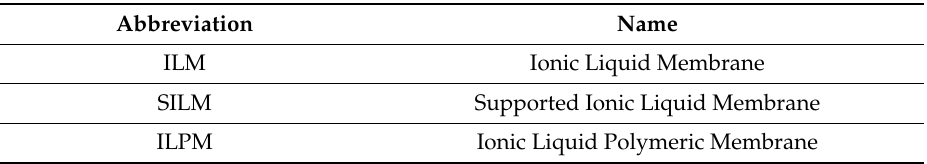
Table 1. Names and abbreviations of the principal Ionic liquid membranes and the primary gases discussed in this